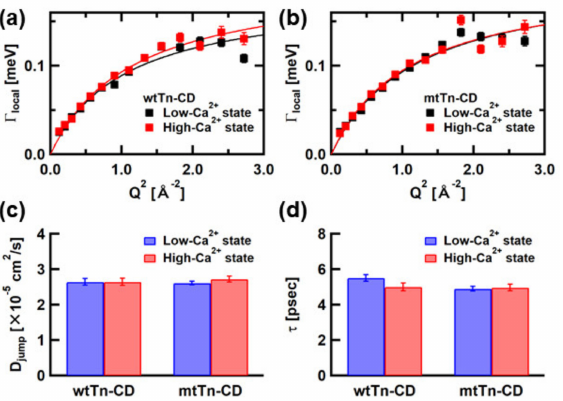
Figure 4. Summary of Q 2 -dependence of Γ local of ( a ) the wtTn-CD and ( b ) the mtTn-CD, and summary of the parameters, ( c ) D jump , and ( d ) the residence time, obtained from the fits with the equation based on the jump-diffusion model to the plots in ( a , b ). Error bars within the symbols are not